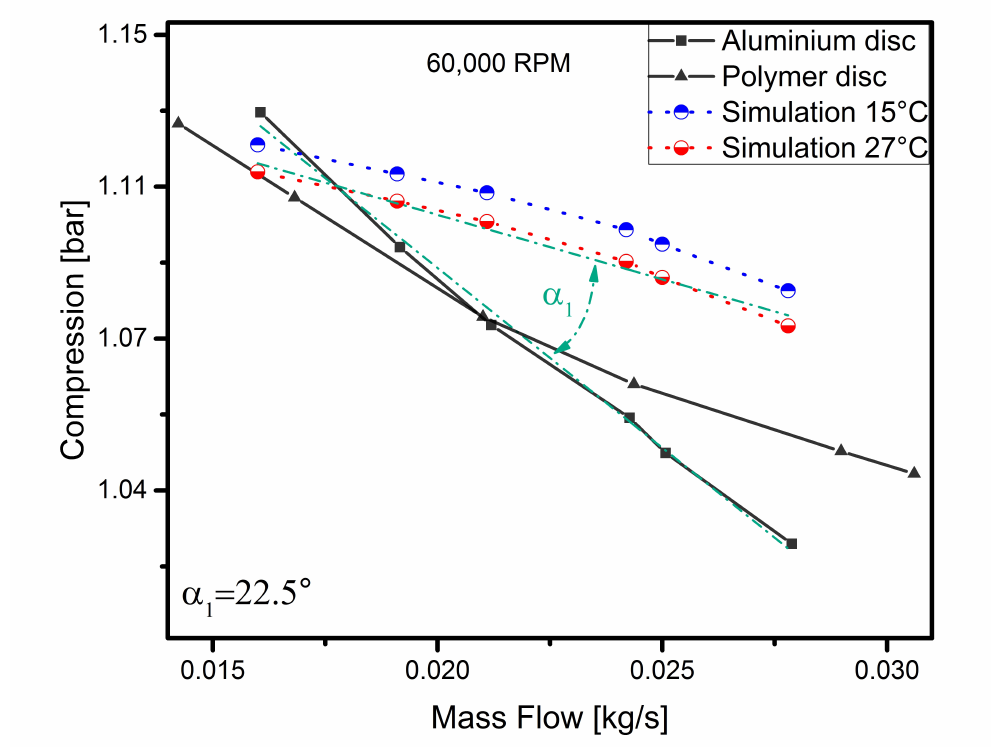
Figure 5. Simulation vs. experimental results for a speed of 60,000